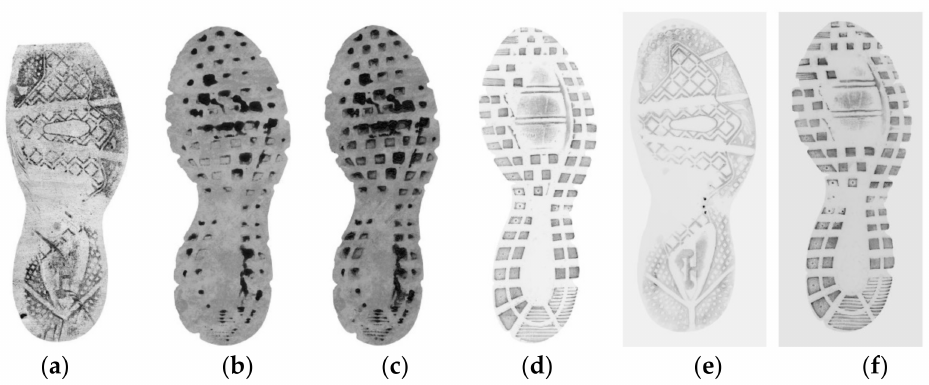
Figure 9. Sample shoeprints in the CS database: ( a ) Dust shoeprint. ( b ) Blood shoeprint. ( c ) Blood shoeprint enhanced by LCV. ( d ) High-quality shoeprint. ( e ) The reference shoeprint of ( a ). ( f ) The reference shoeprint of ( b – d